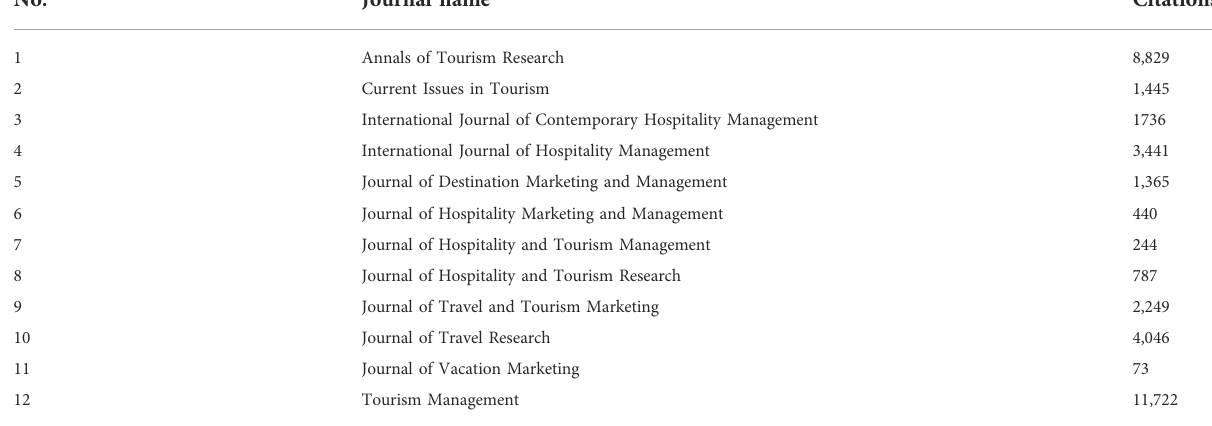
TABLE 4 Most cited journals (Hospitality and